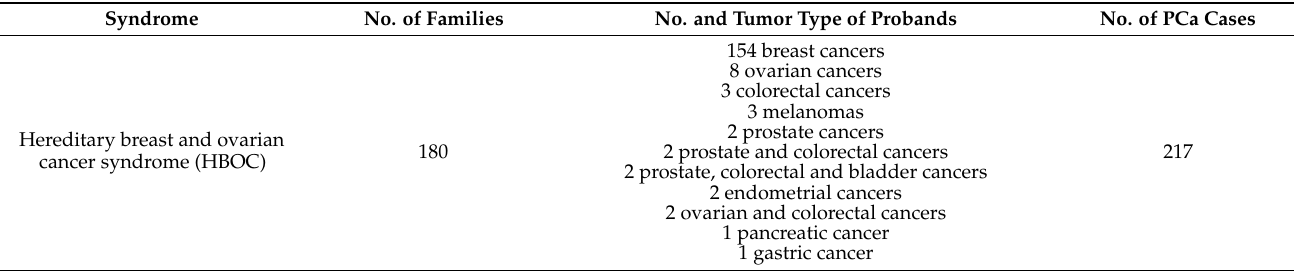
Table 1. Number and tumor type of HBOC